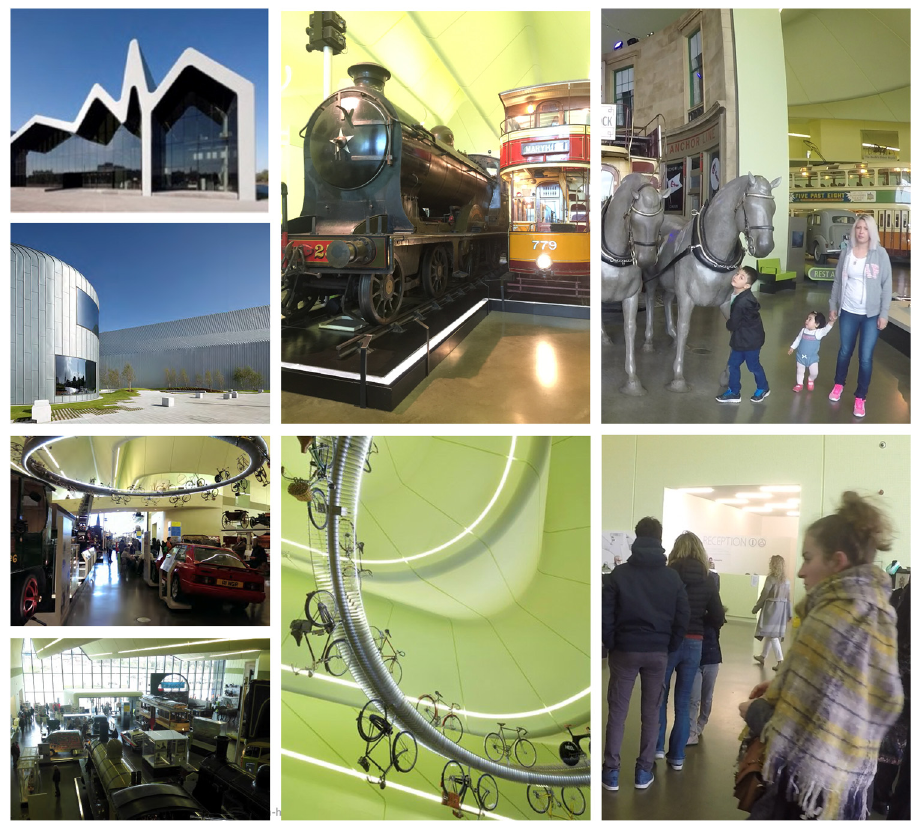
Figure 5. Representation of the spatial qualities of the Riverside Museum in Glasgow. (Photos by A. Salama).